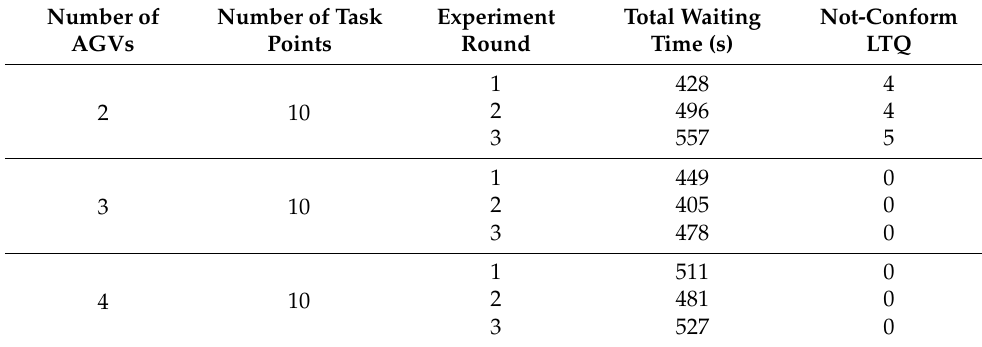
Table 7. The experimental results of different number of AGVs at 10 task points.